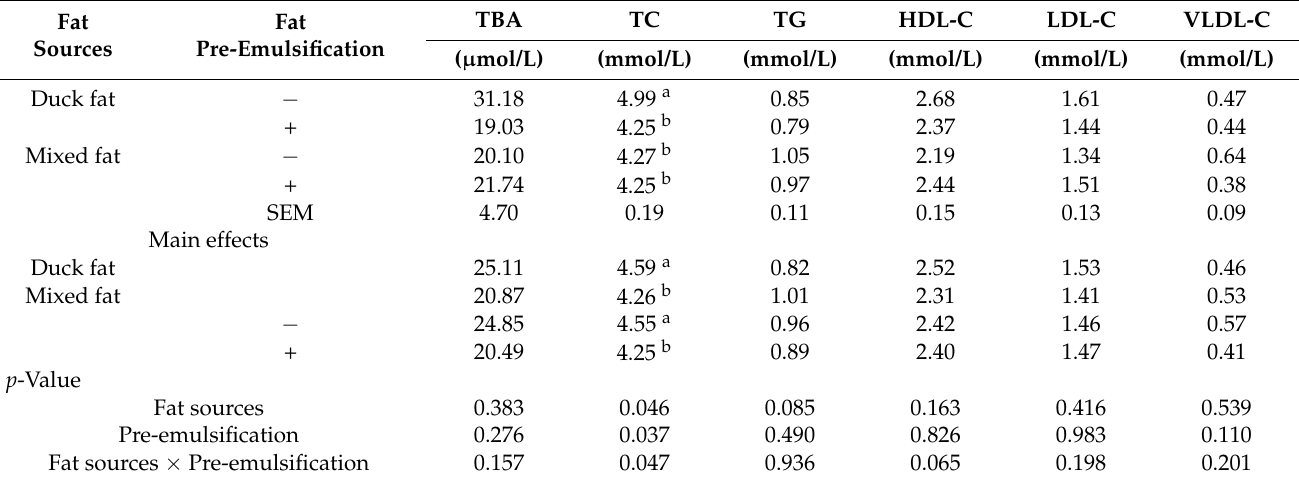
Table 4. Effects of fat sources and pre-emulsification on serum biochemical index of ducks at 34 days of age 1,2 .